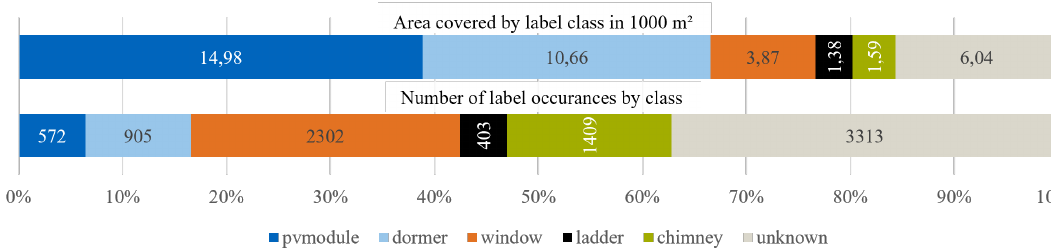
Figure 3. Class balance of the superstructure